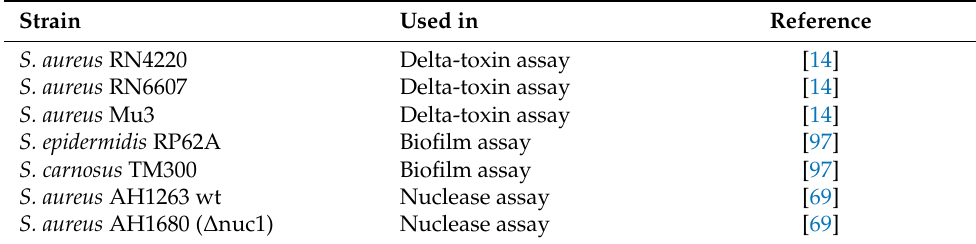
Table A1. Reference strains used in this study.